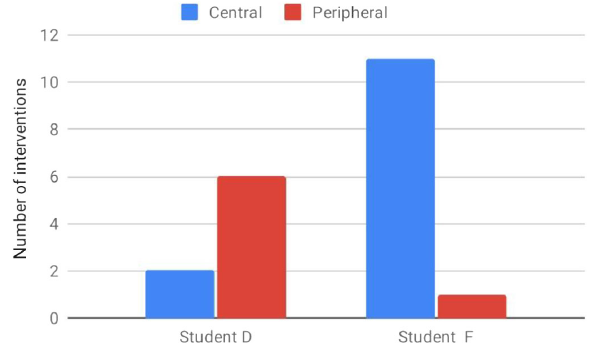
FIG. 4. Students ’ intervention types during segment